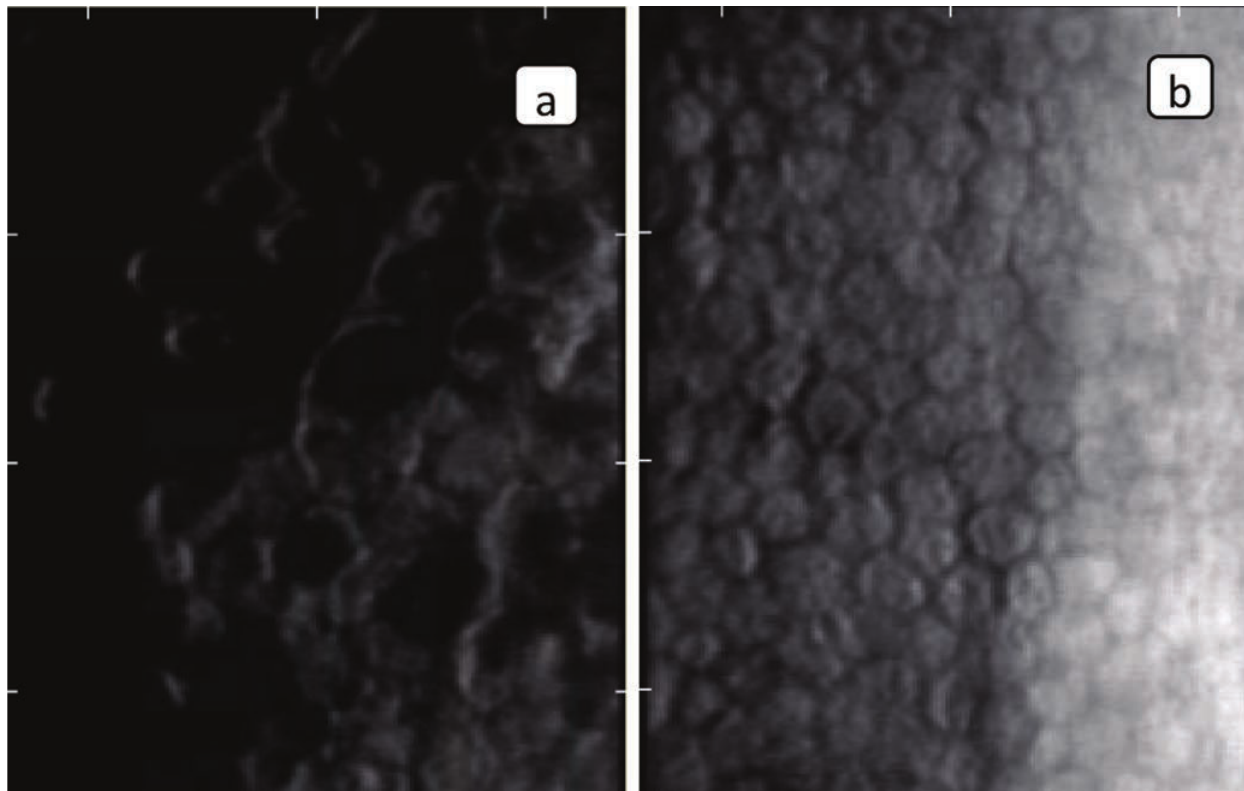
Figure 2. (a) Endothelial cells parameters in eye with FED. (b) Endothelial cells parameters in